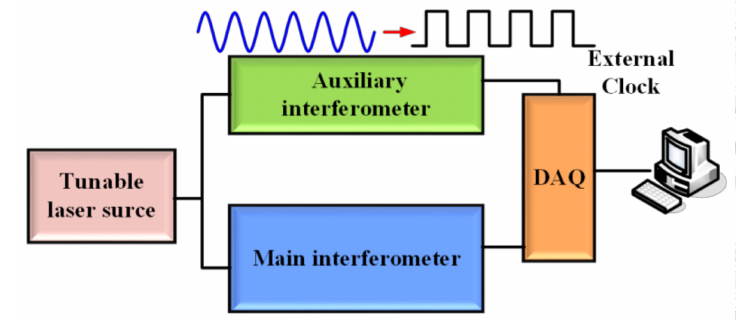
Figure 3. Frequency-sampling method for compensation of nonlinear phase noise in OFDR, DAQ is a data acquisition